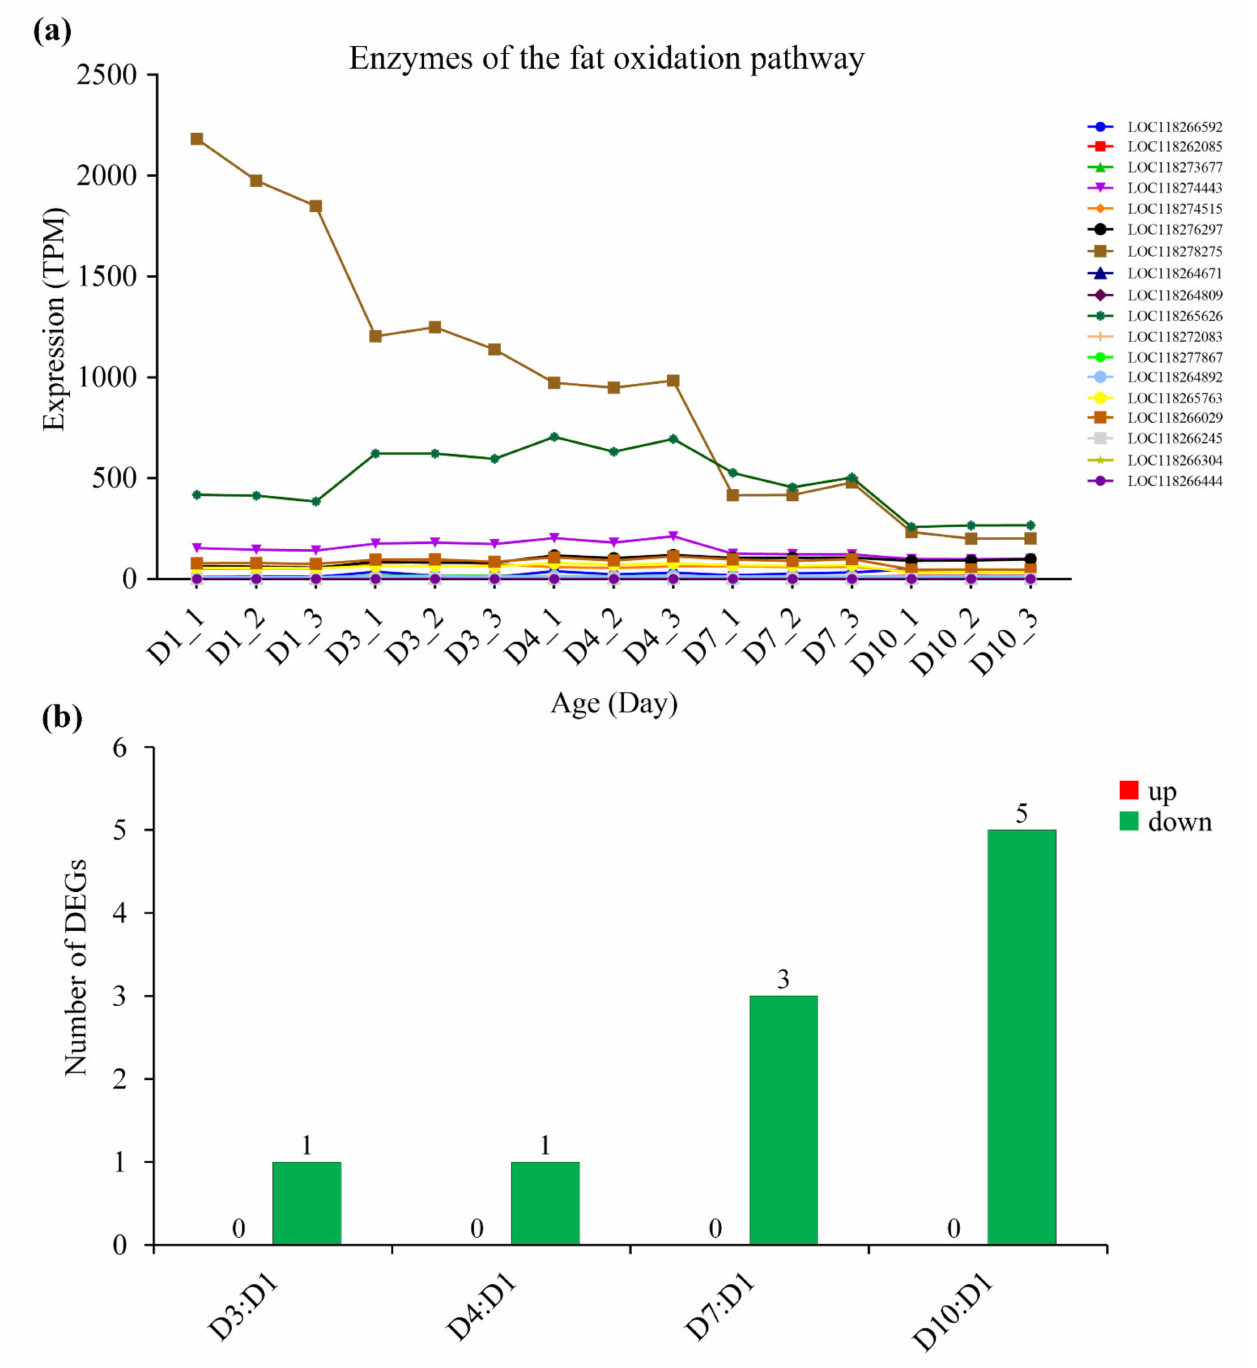
Figure 6. The expression of enzymes of the fat oxidation pathway in S. frugiperda females at different ages. ( a ) Changes in enzyme gene expression with age; ( b ) DEGs of D3:D1, D4:D1, D7:D1 and D10:D1 groups, wherein red columns represent upregulated DEGs and green columns represent downregulated